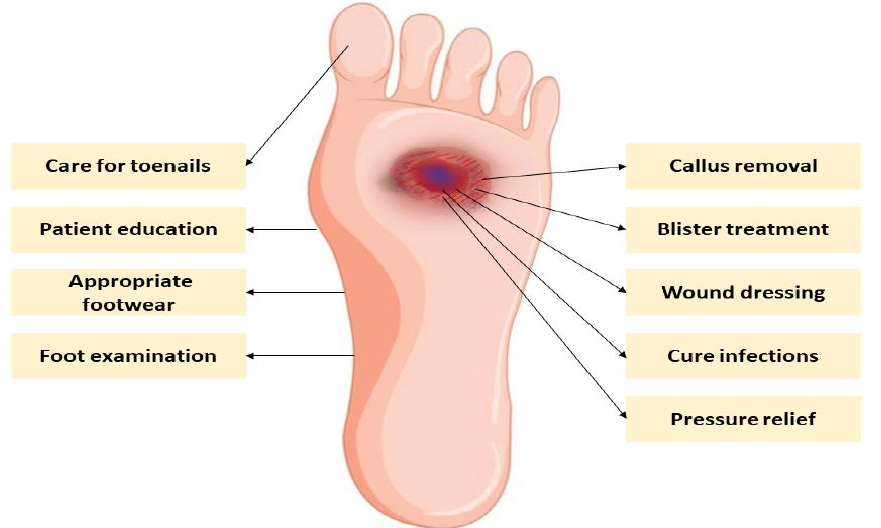
Figure 6. Prevention and management of diabetic foot conditions.